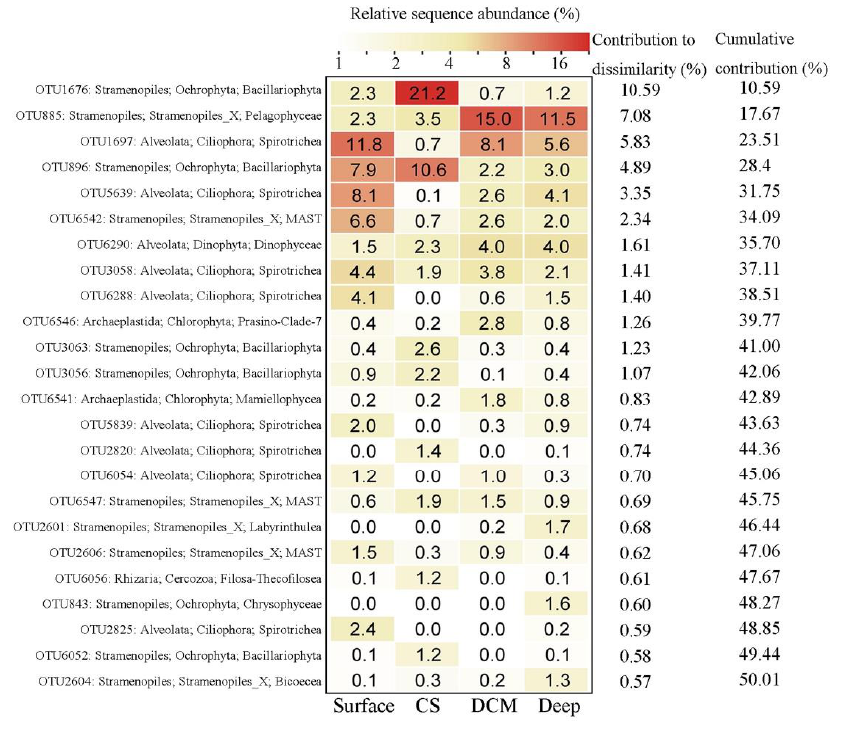
Figure 5. Taxonomic identities of the top 24 OTUs that contributed most to community dissimilarities among the four groups with their relative contributions to each group. Table 2. Spearman’s correlation coefficients between alpha diversity estimates and environmental variables. When the correlation is significant both r- and p -values are underlined ( p < 0.05) or in bold ( p <